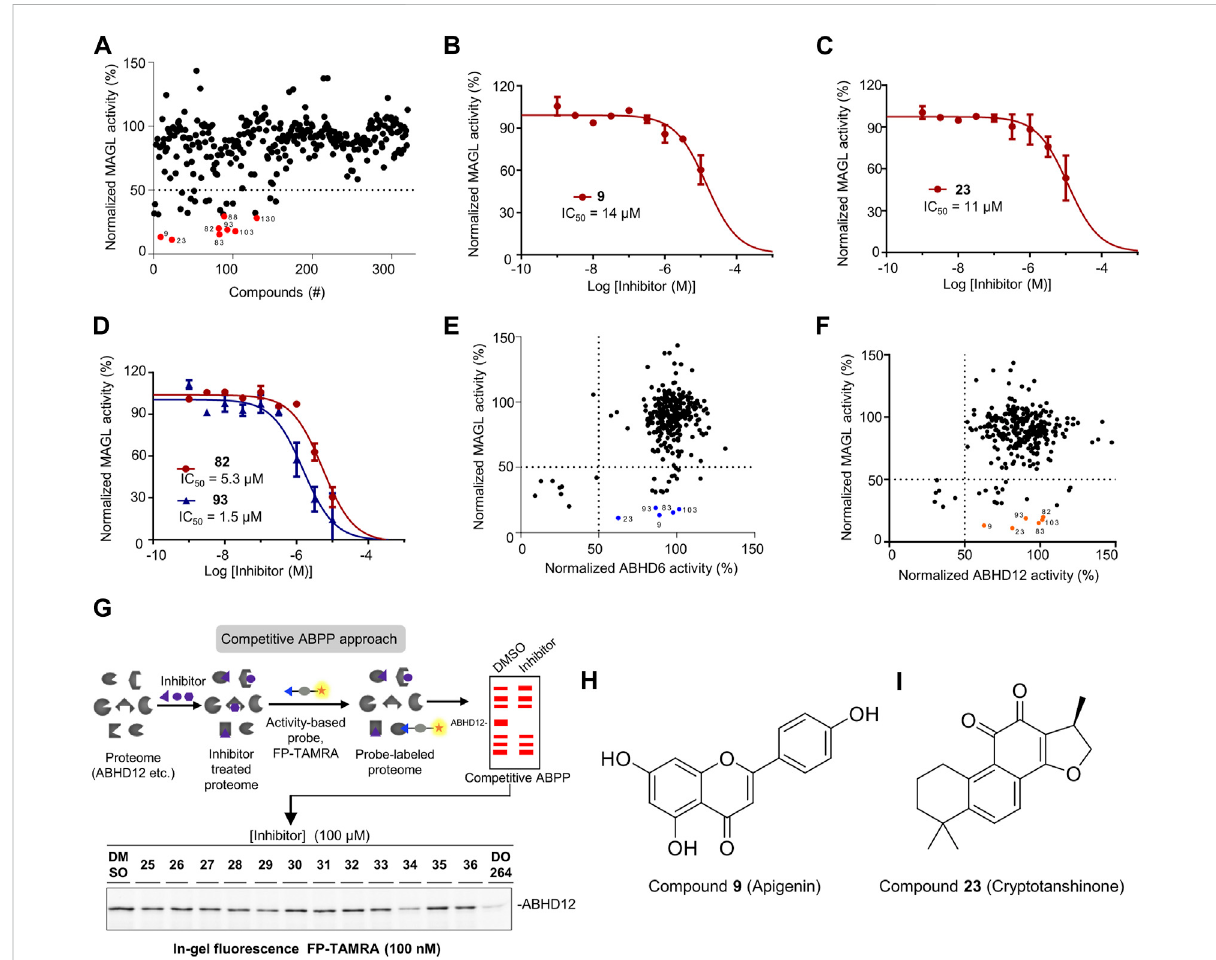
FIGURE 3 Screening the focused library of natural organic compounds to identify MAGL inhibitors selective over ABHD6 and ABHD12. (A) A total of 320 compounds were screened in duplicate (N = 2) at 100 µM using the AA-HNA -based assay against MAGL. Among them, 26 compounds showed > 50% inhibitory activity and 8 compounds (indicated in red) showed > 70% inhibitory activity and were selected for further concentration- response analysis. (B – D) Concentration-dependent inhibition of MAGL activity by compounds 9 (B) , 23 (C) , 82 and 93 (D) as measured by the AA-HNA assay. Data represent means± SEM, n= 4 per group. (E) Analysis ofMAGL inhibition vs.ABHD6inhibition (100 µM compounds). (F) Analysis of MAGL inhibition vs. ABHD12 inhibition (100 µM compounds). (G) Representative gels of competitive activity-based protein pro fi ling (ABPP)